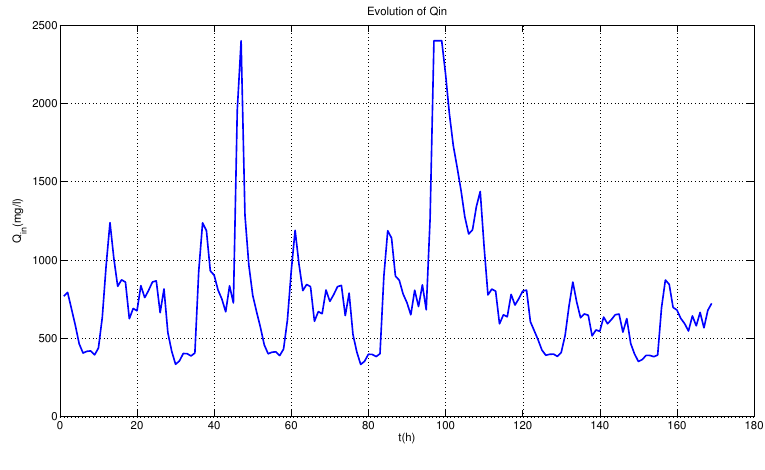
Figure 3. Influent flow Q in for stormy weather.